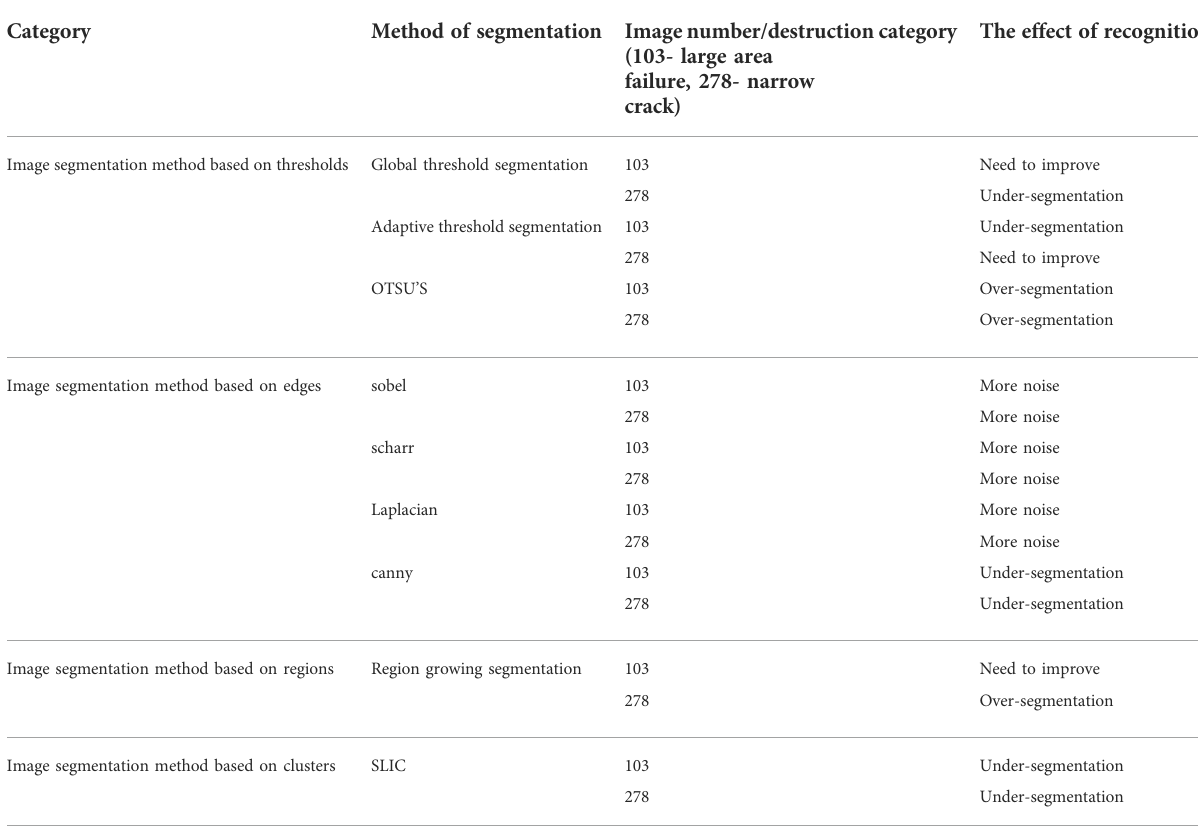
TABLE 3 Comprehensive comparison of image segmentation